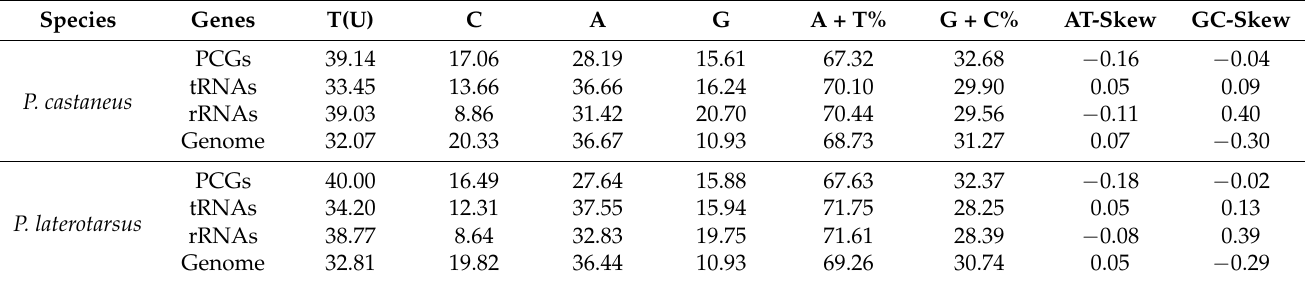
Table 4. Base composition of two newly mitochondrial